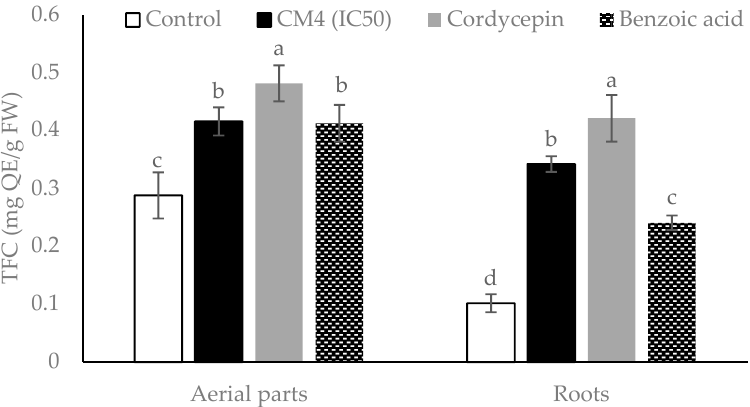
Figure 6. Total flavonoid contents ( TFC) of radish among control, CM4 fraction, synthetic cordycepin and BA at 0.04 mg/mL. Columns with different superscript letters ( a,b,c,d ) in the aerial parts and roots indicated significant differences at p < 0.05 by Fisher’s test.